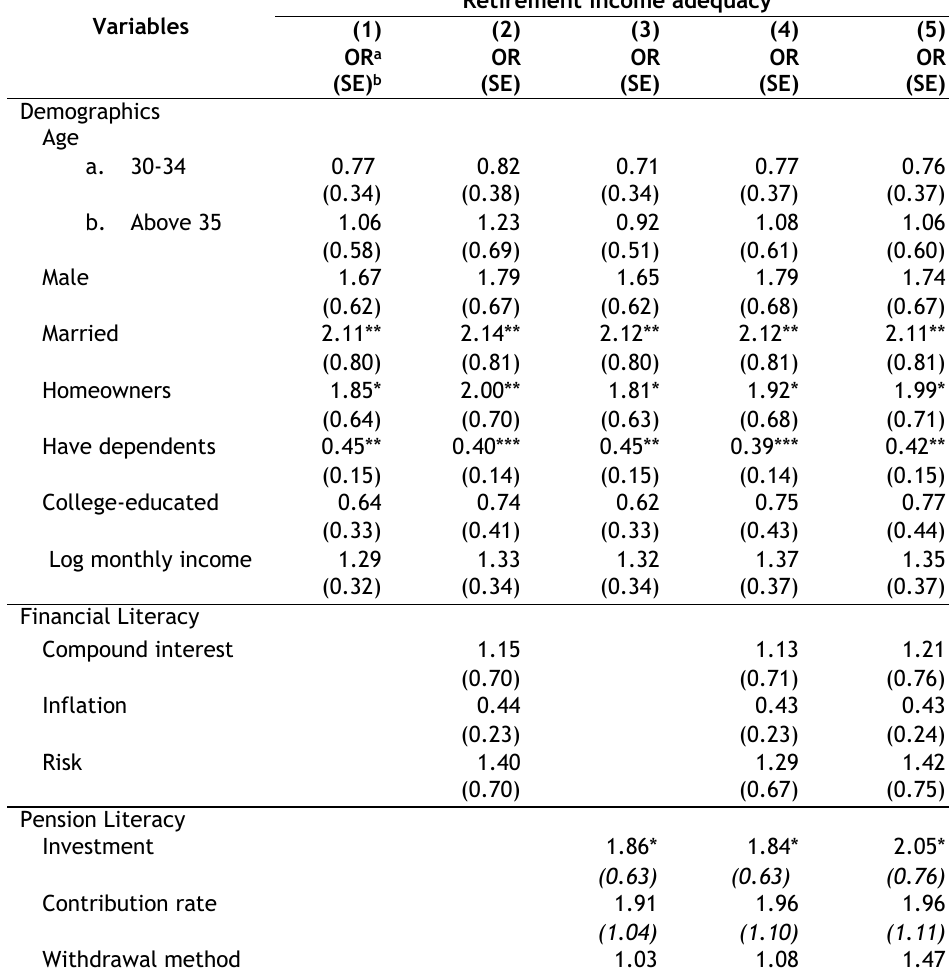
Table 4. Ordered logistic regression results for retirement income adequacy